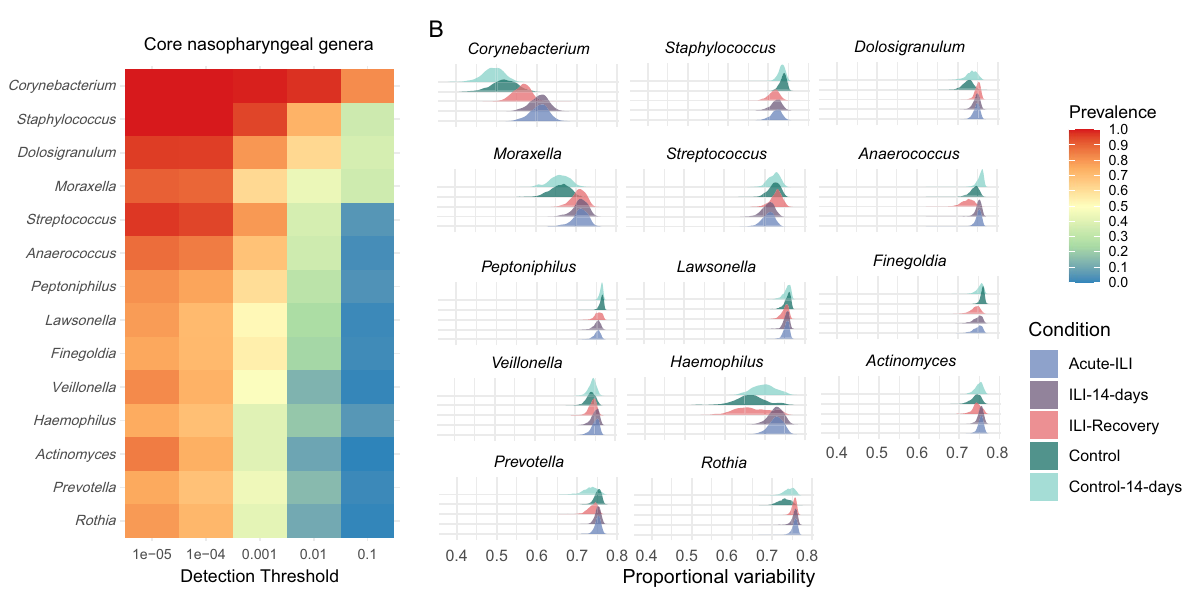
Figure 3. Genera associated with ILI status, medications and demographics. ( A ) Genus-level associations with an FDR < 0.05. ( B ) A heatmap showing prevalence of each of the genera in acute-ILI and control groups. ( C ) Comparison of relative abundances of four genera associated with ILI status.